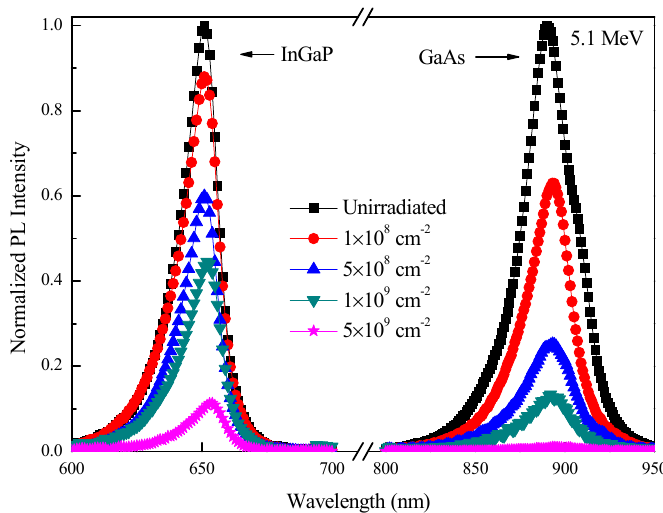
Figure 4. Photoluminescence (PL) spectra at room temperature of the InGaP top cells and GaAs middle cells before and after alpha-particle irradiation with various fluences.